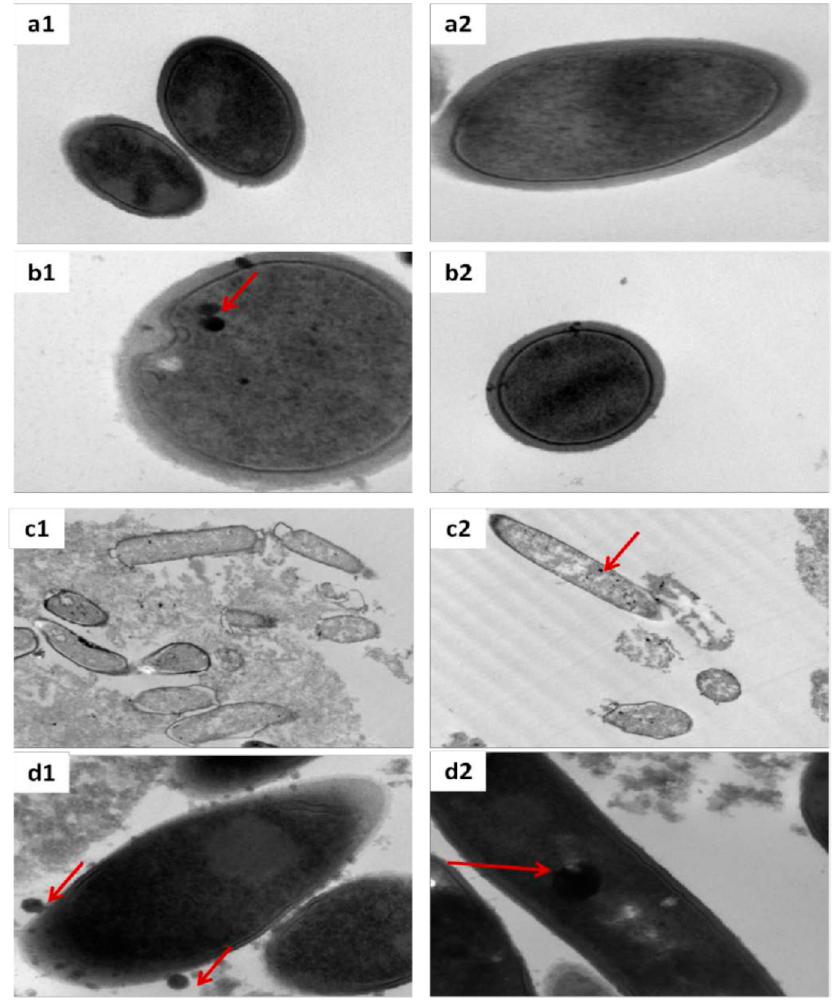
Figure 7. Transmission electron micrographs of un-exposed bacteria ( a1 , a2 ) and exposed bacteria treated with 10 μ g·mL − 1 of Se for 48 h, as CS-SeNPs ( b1 , b2 ), ethoxylated-SeNPs ( c1 , c2 ) and HEC-SeNPs ( d1 , d2 ). Red arrows indicate the presence of nanoparticles.